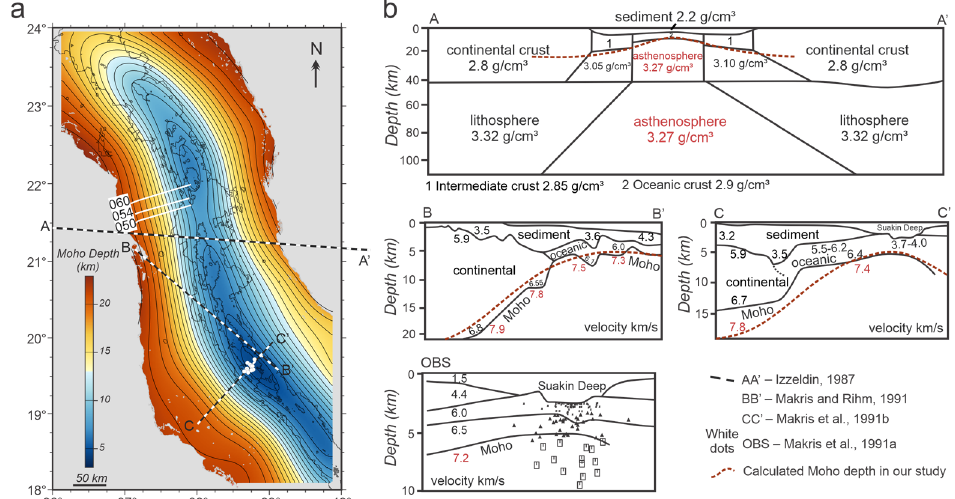
Figure 3. Calculated Moho depth and comparison with published data. ( a ) Moho depth from gravity inversion. Black lines show the isobaths of the calculated Moho depth. Grey lines along the rift axis represent the isobaths of − 900 m and − 1800 m bathymetries. White lines indicate reflection seismic profiles in this study. Black and white lines (AA’ [78], BB’ [47], CC’ [79]) represent locations of the published density and velocity structures. White dots on the line CC’ show the distribution of OBS stations within the Suakin Deep [9]. ( b ) Published density and velocity structures [47,78,79] and microearthquakes records [9]. Red dashed lines indicate calculated Moho depths along published profiles.